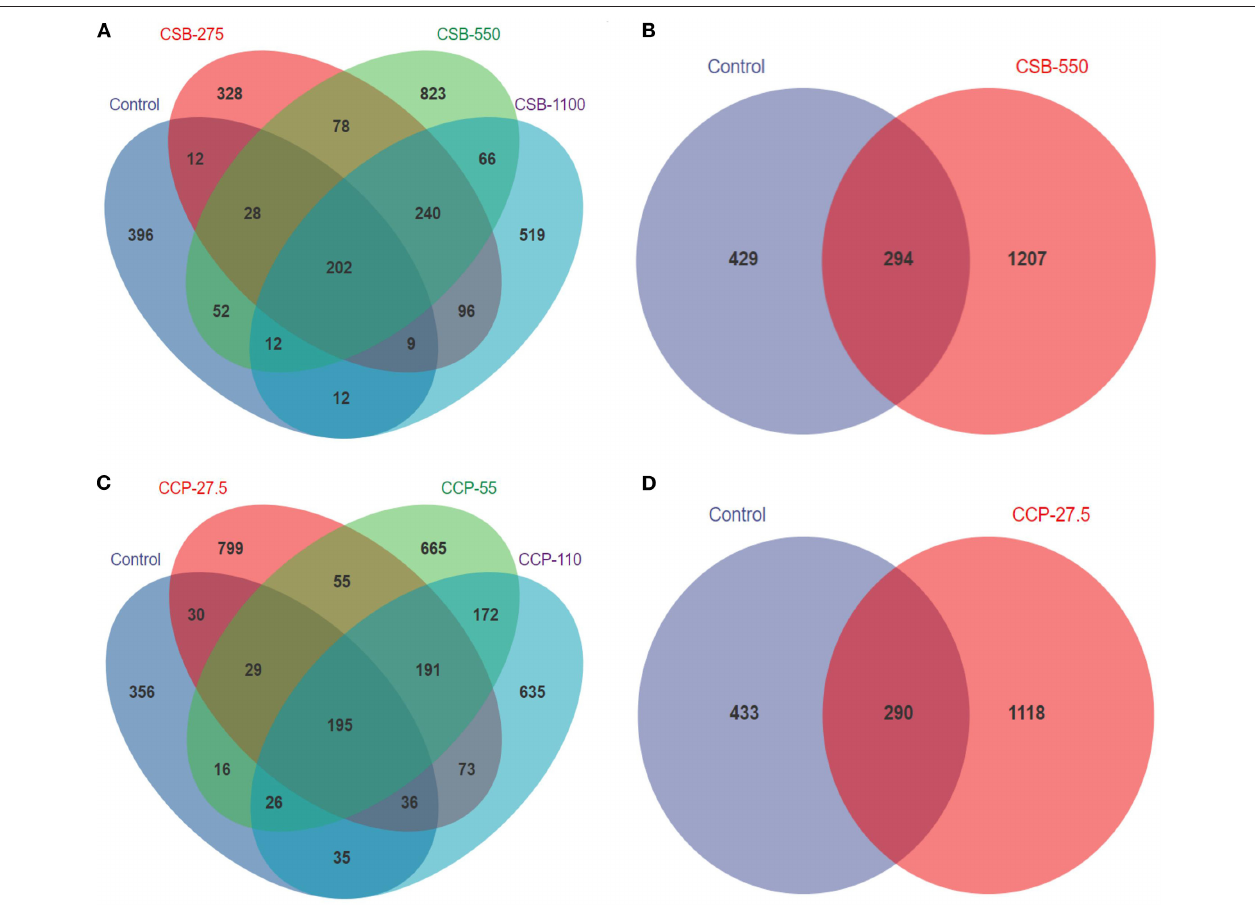
FIGURE 1 | The number of shared and specific operational taxonomic units (OTUs) in each group. Each circle represents one group; the number in the overlapping portion of the circles represents the number of shared OTUs between the different groups, and the number in the non-overlapping portion of the circles represents the OTUs specific to each group. (A) Between squabs fed the CSB diet and the control diet. (B) Between groups CSB-550 and control. (C) Between squabs fed the CCP diet and the control diet. (D) Between groups CCP-27.5 and control.